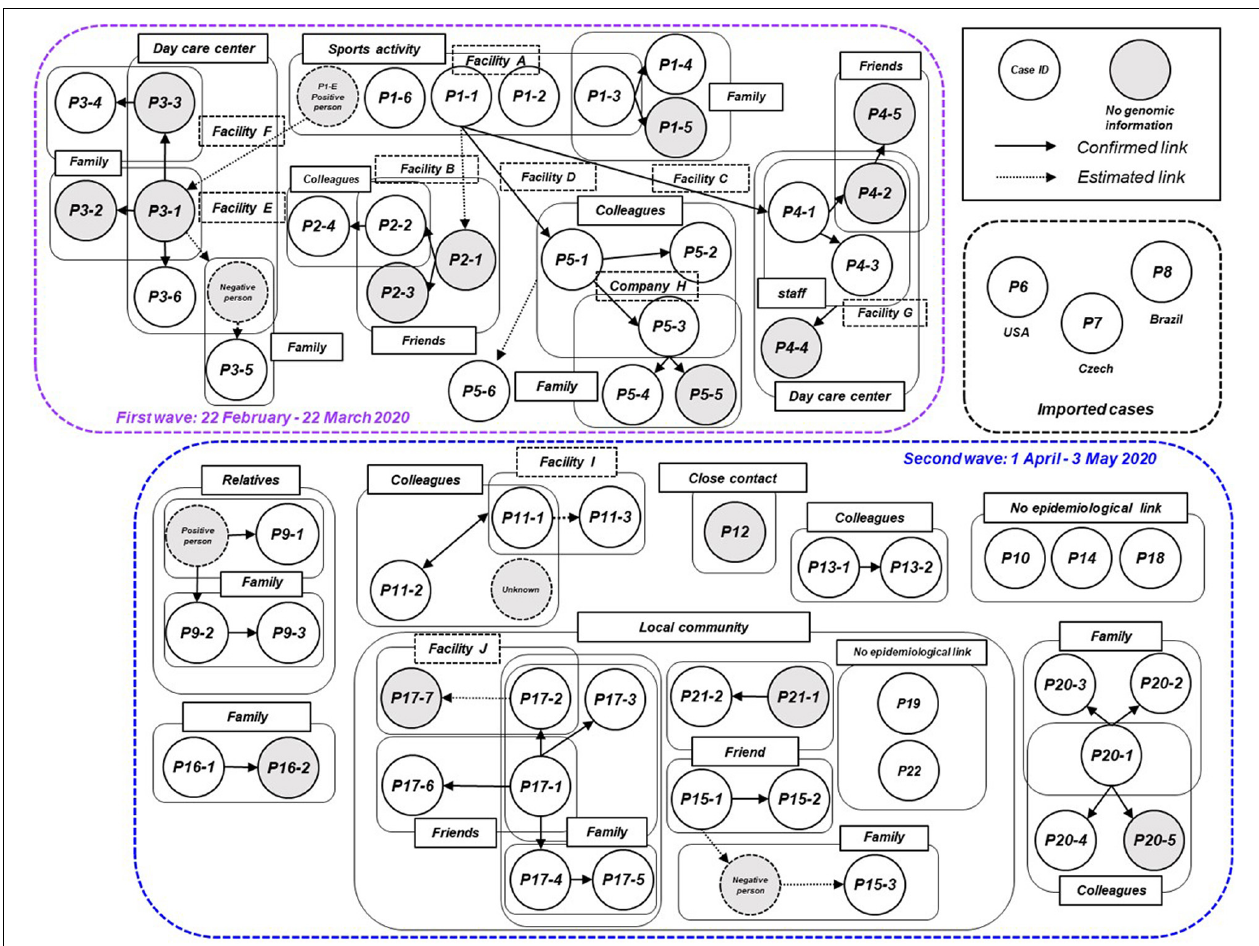
FIGURE 3 | Transmission chain of the COVID-19 outbreak, Niigata City, Japan, between February and May 2020 ( n = 63). Diagram showing the contact relationships of patients, including the 63 symptomatic cases in this study. The purple dotted box represents the first wave by the date of onset (between 22 February and March 22, 2020) and the light blue dotted box represents the second wave by the date of onset (between 01 April and May 03, 2020). The circles indicate each patient and are assigned a case ID. Gray circles indicate cases for which no genomic information was available, dotted circles indicate cases with negative qualitative reverse transcription polymerase chain reaction (RT-qPCR) results or unidentified cases. A large pale blue frame indicates common indoor environment, facility of transmission patients (e.g., family, colleagues, friends, and faculties), or community transmission. Arrows indicate established link and dotted arrows represent the most plausible link, both based on contact tracing. The case ID of each patient corresponds to the haplotype network in Figure 5 and detailed epidemiological information of Supplementary Table 4